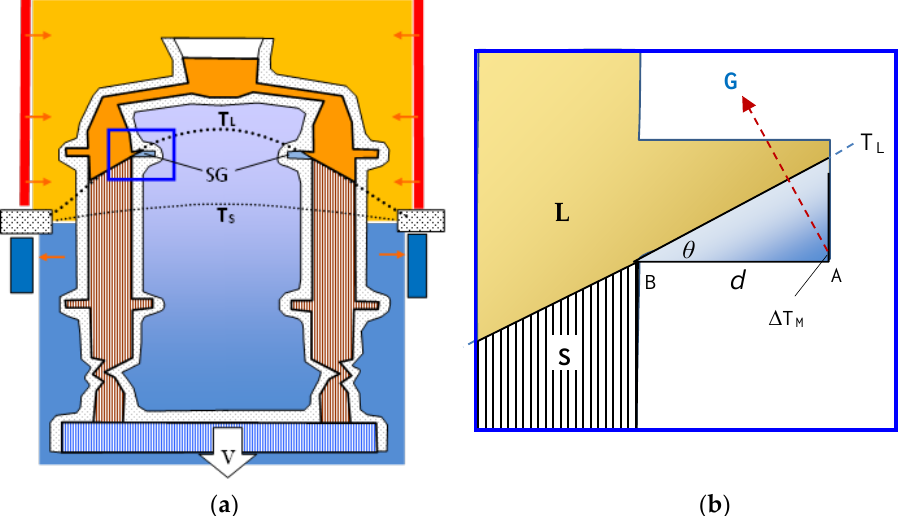
Figure 10. ( a ) Schematic to show the solidification process of blade castings during the withdrawal process in the Bridgman furnace; ( b ) magnified view of the blue frame area in ( a ) to illustrate the geometrical undercooling at a platform extremity. (T L : liquidus temperature, θ : inclination angle, G: temperature gradient, ∆ T M : maximum undercooling, d : expansion